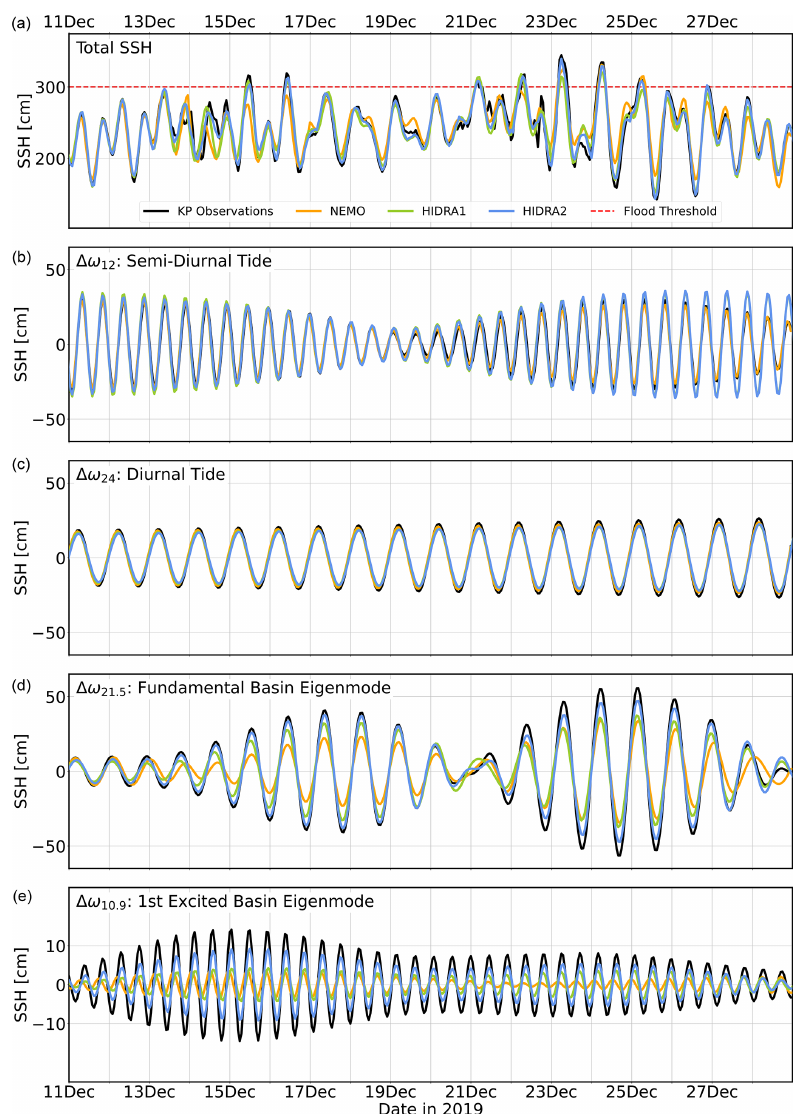
Figure 16. Same as Fig. 15 but for the December 2019 coastal